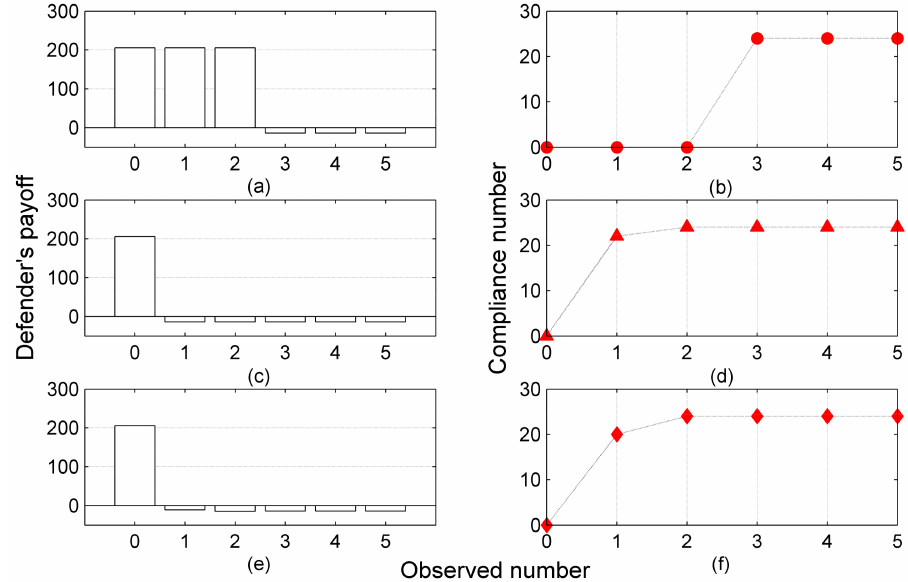
Figure 3. Defender’s payoff and compliance number under different observation number (( a ) is the defender’s payoff under piecewise function; ( b ) is the compliance number under piecewise function; ( c ) is the defender’s payoff under exponential fall function; ( d ) is the compliance number under exponential fall function; ( e ) is the defender’s payoff under power law function; ( f ) is the compliance number under power law